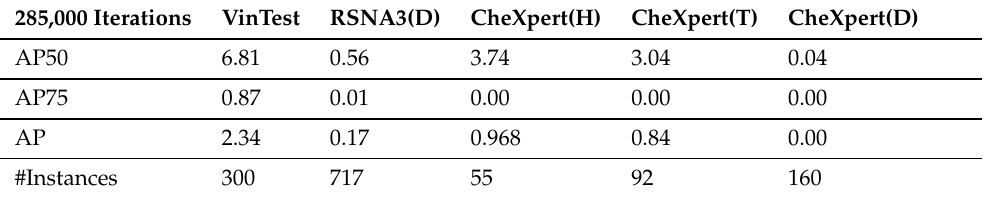
Table 5. Lung lesion detection training on VinBig.